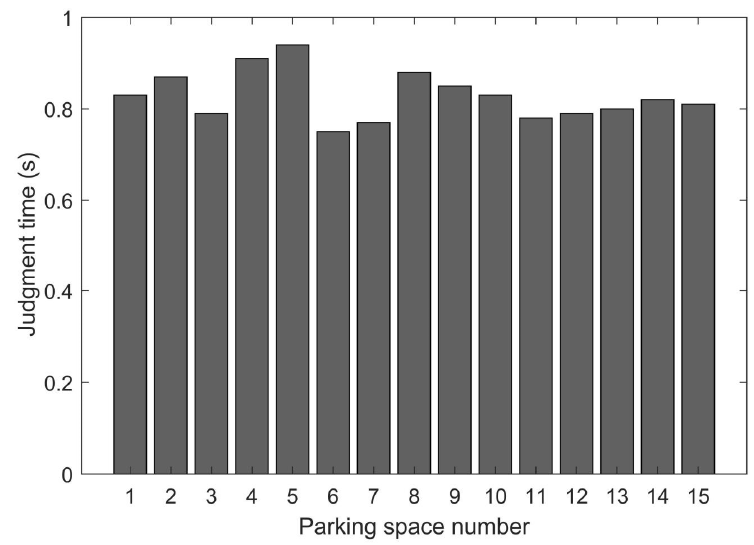
Figure 11. Judgment time for each parking space.